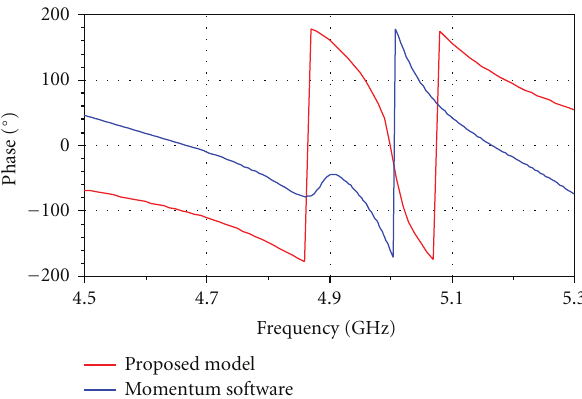
Figure 11: The antenna array input-reflected phase.